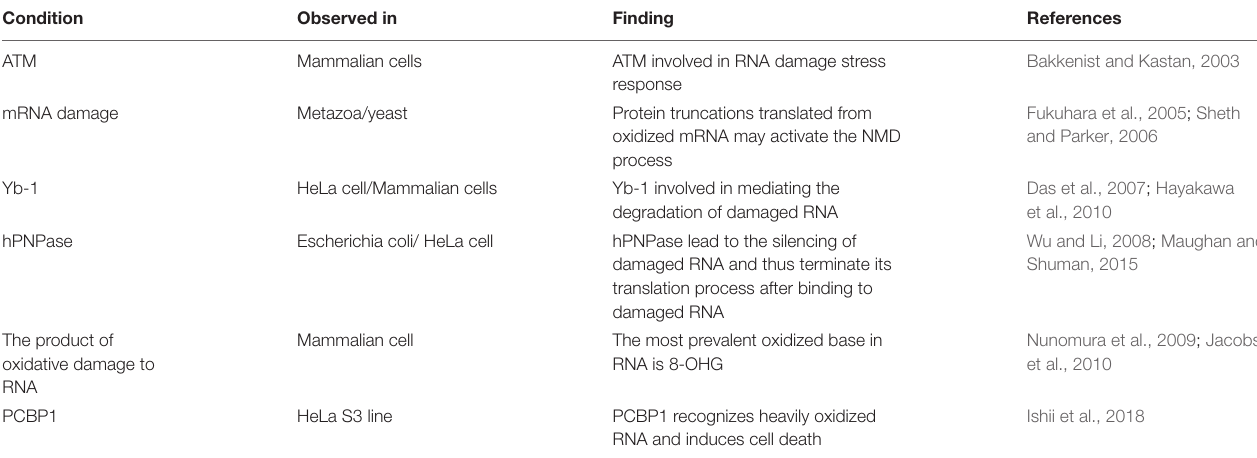
TABLE 1 | Summary the research progress of RNA oxidative damage mechanism.